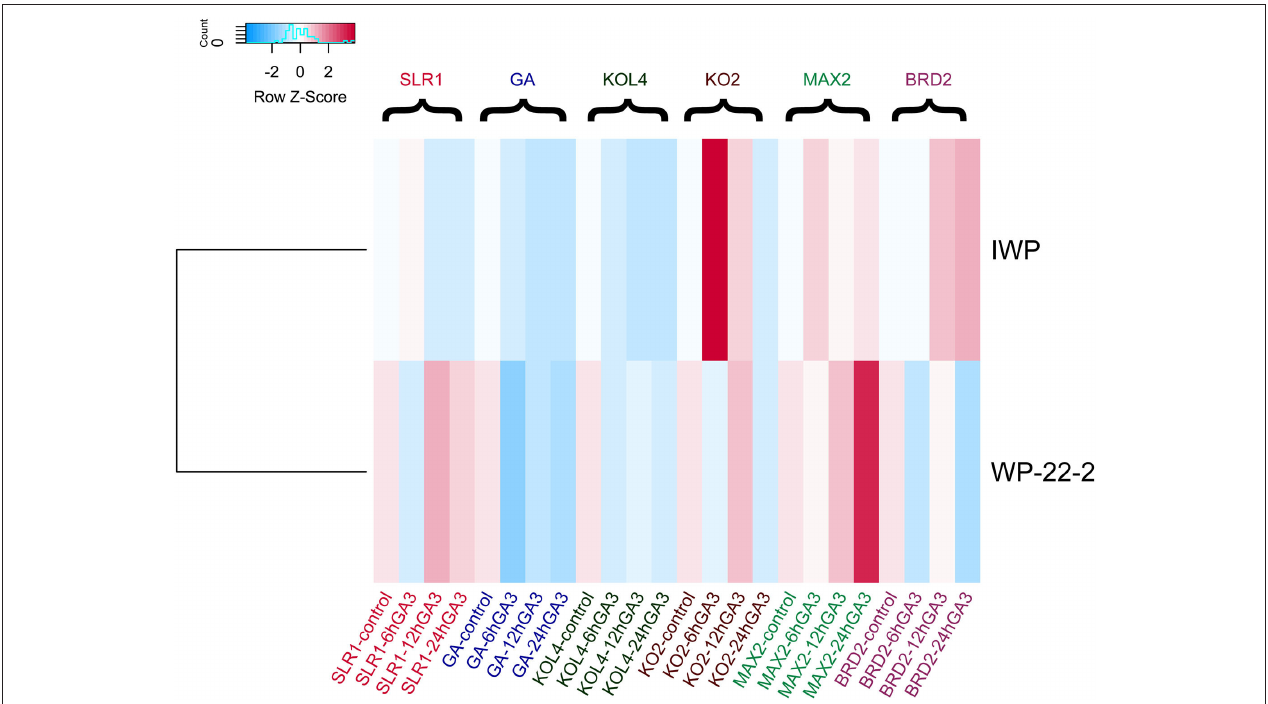
FIGURE 2 | Heatmap of the gene expression data of IWP and WP-22-2. ddC T values of the quantitative real time polymerase chain reaction (qRT-PCR) were plotted. Clear expression changes were observed for the genes KO2 (ent-kaurene oxidase2), MAX2 (Fbox/LRR repeat MAX2 homolog), and brassinosteroid deficient 2 (BRD2) between IWP and the mutant